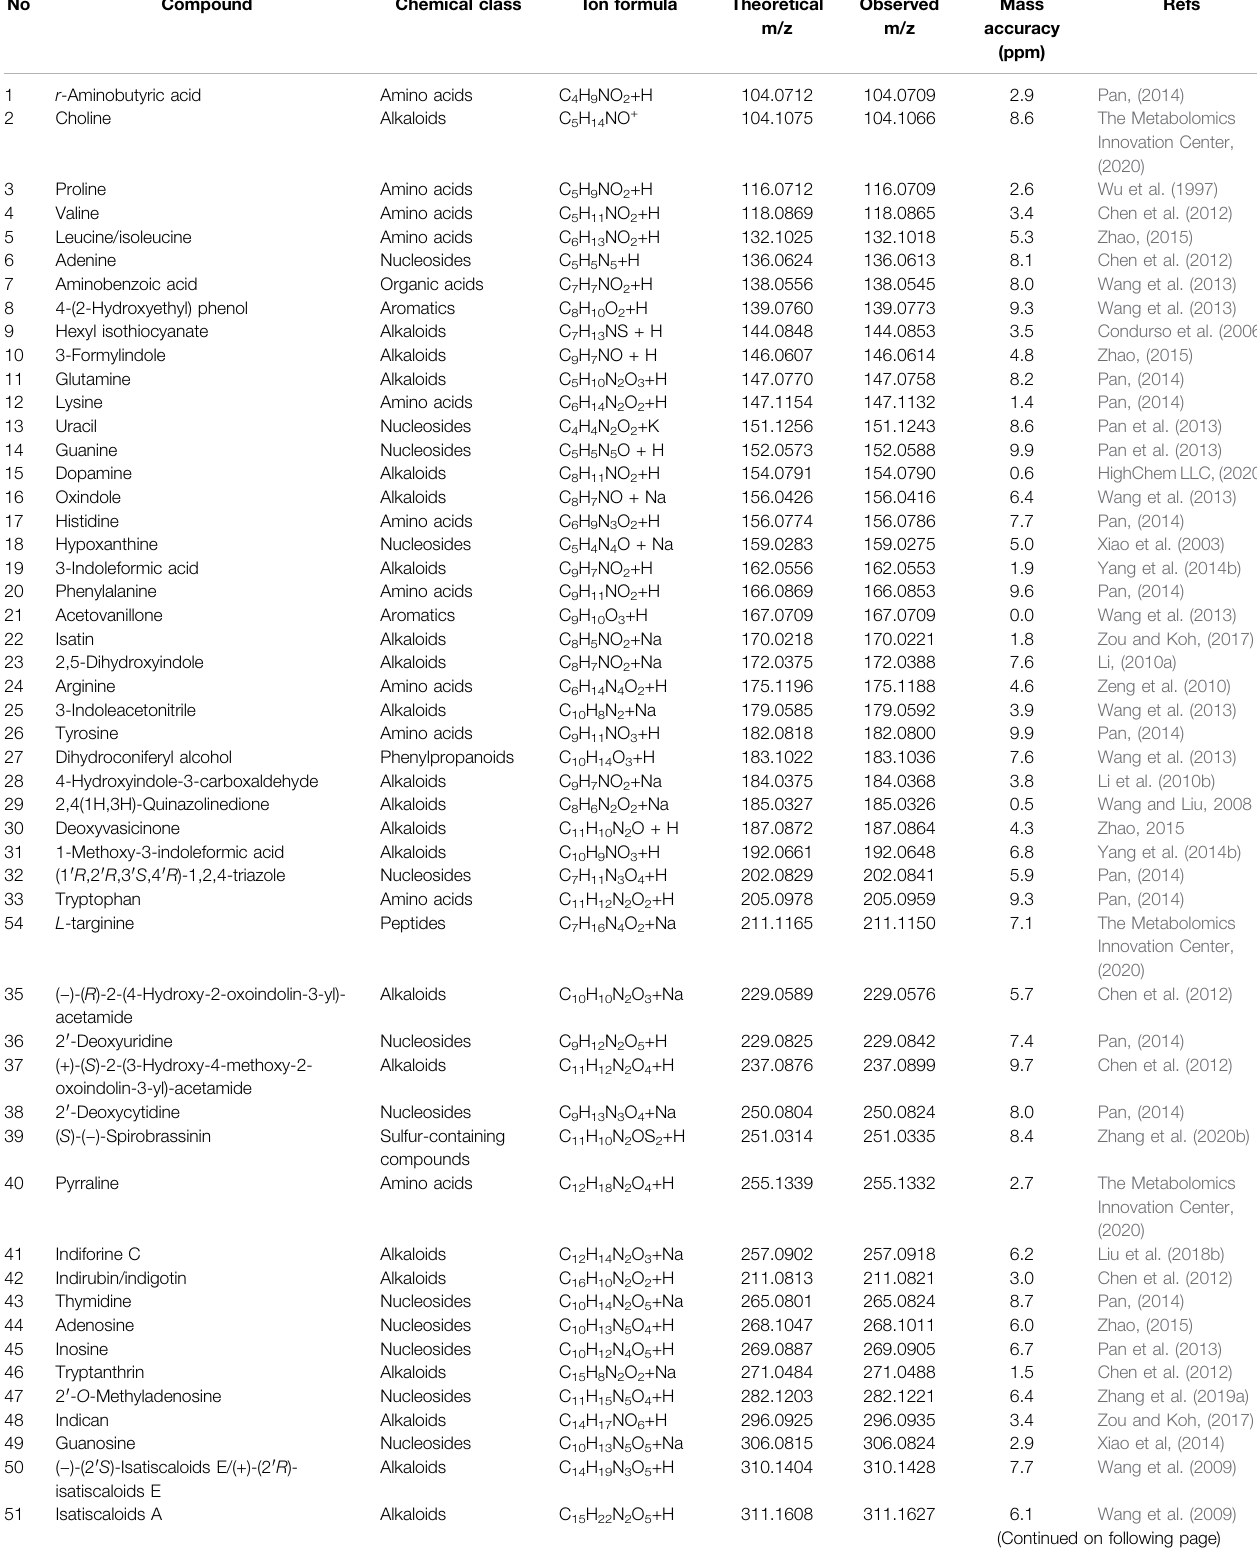
TABLE2| Assignmentofionsobservedinthematrix-assistedlaserdesorptionandiontrap – time-of- fl ight(MALDI-IT-TOF)massspectrometryimaging(MSI)ofthedriedroot of Isatis indigotica with references regarding shown